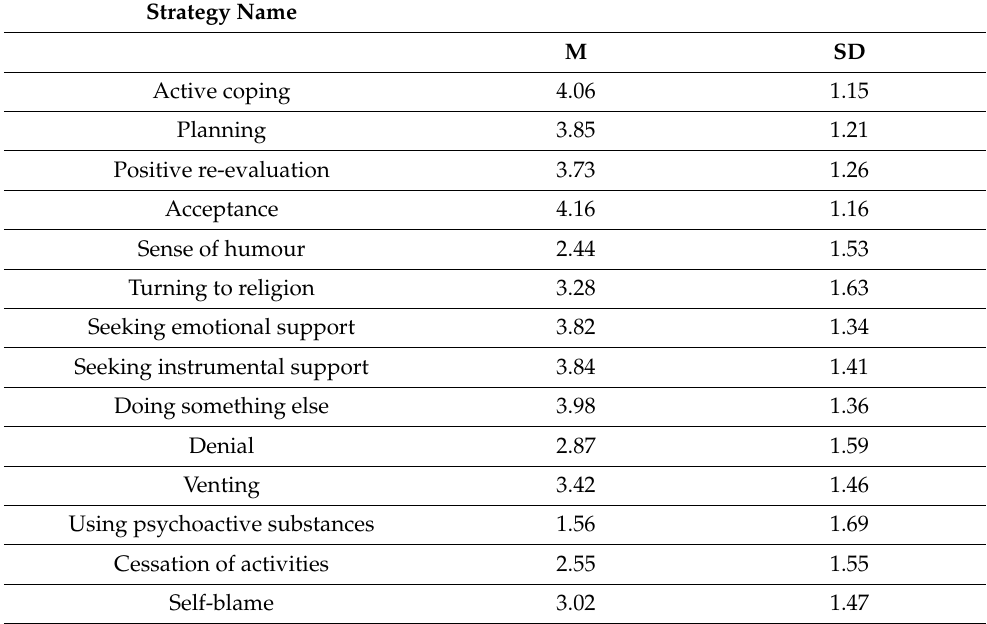
Table 1. Strategies of coping with stress among